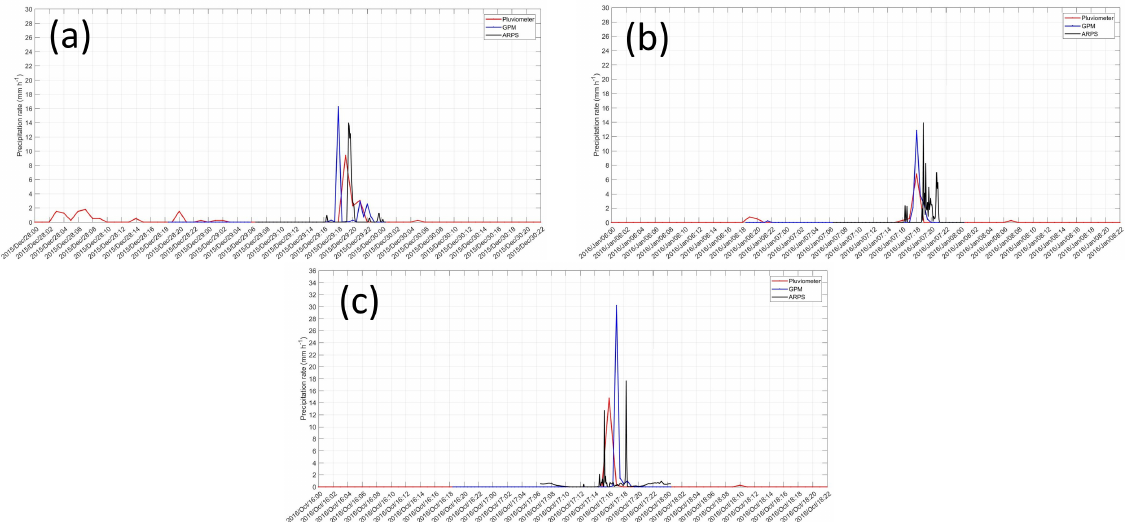
Figure 3. Time series of precipitation rate (mm h − 1 ) above the Huancayo observatory obtained from in-situ pluviometer (red line), GPM (blue line) data and ARPS model (resolution: 0.5 km) (black line) for ( a ) TS1; ( b ) TS2 and ( c ) TS3